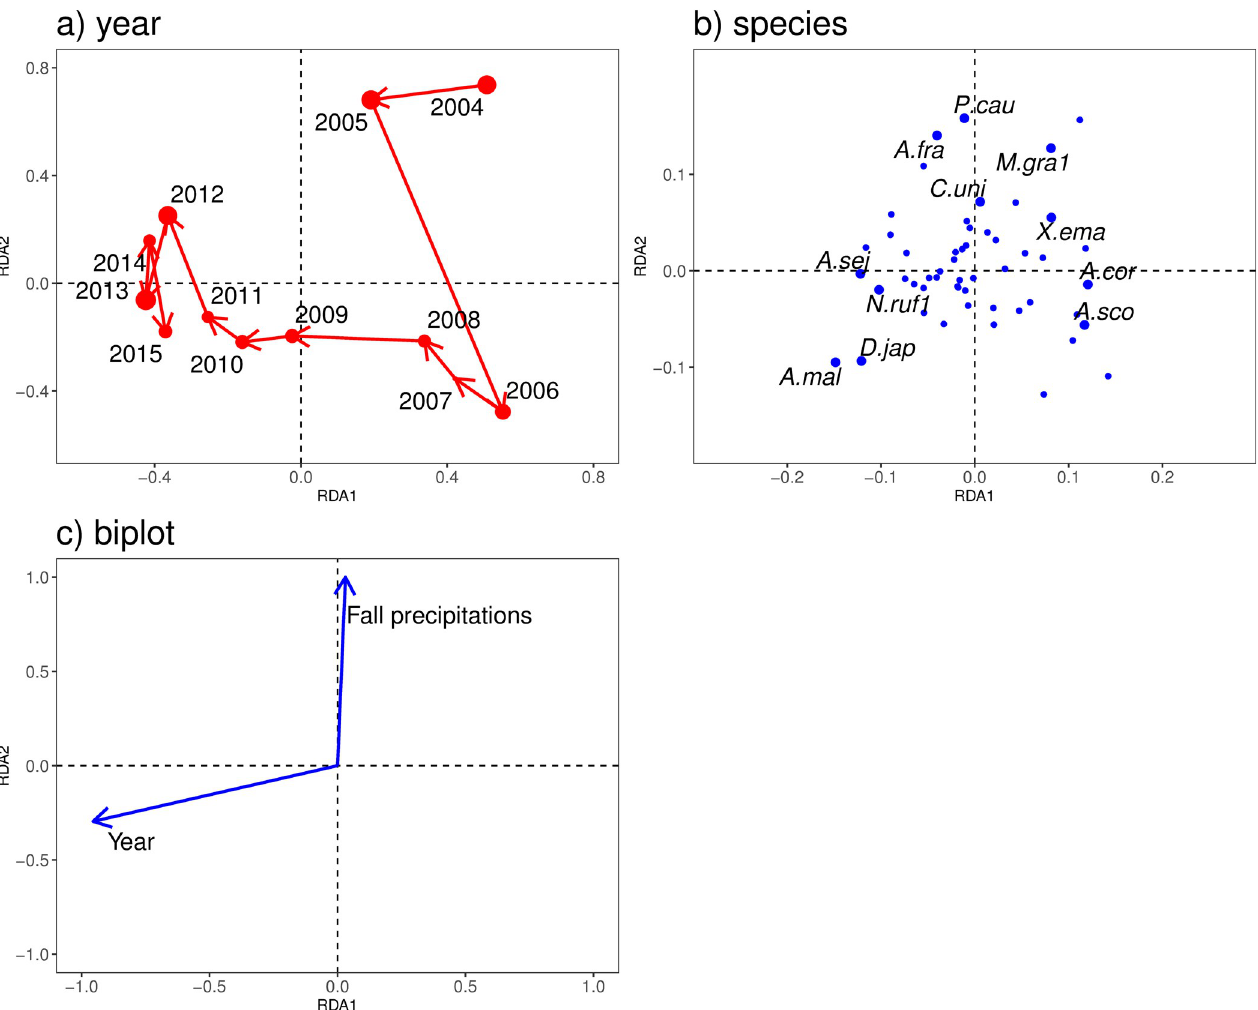
Fig 2. RDA ordination diagram of the species composition of longhorn beetles (Cerambycidae and Disteniidae) at Ito city (a: plot by year, b: species plot, c: biplot). The size of the circles in panel a represents the total number of longhorn beetles captured each year (e.g. 44 individuals in 2007 and 173 in 2013). See S1 Table for the species codes in panel b. Only those having statistically significant correlations to Year and Fall precipitations and A . mal are displayed in panel b.